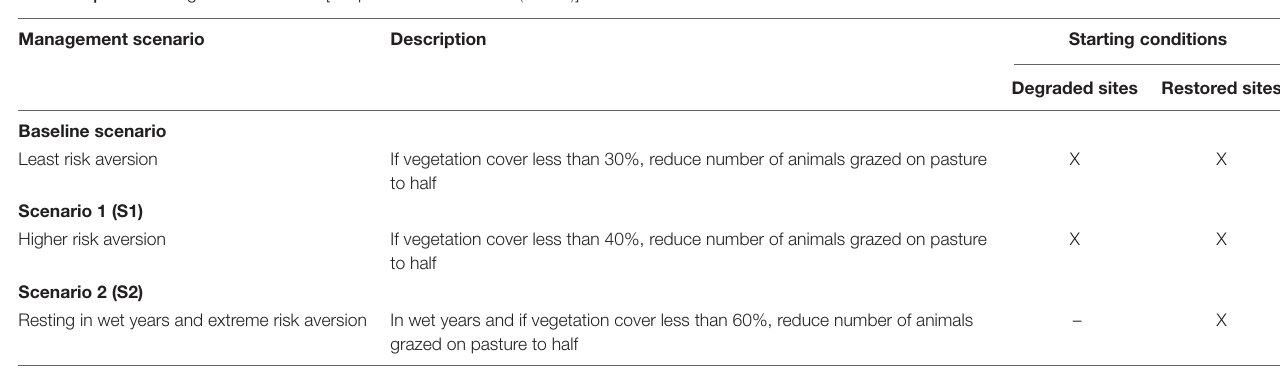
FIGURE 9 | Cost-efficiency of management interventions dependent on stability domains and window of opportunity. Blue, gray, and red areas in panels (A–C) represent gross future values of the benefits of intervention, the benefits that would have occurred without intervention and costs of intervention, respectively. Gross future benefits depend on productivity levels, which vary between stability domains. In panels (D–F) , the same investments of panels (A–C) are converted to discounted (present) value of investment costs and benefits. Dotted lines refer to net present value of intervention (i.e., subtracting from gross benefits the intervention costs and any benefits that would have been obtained without the intervention). The middle panel indicates management effects concurring with a window of opportunity. Note the declining level of initial investment costs and recurrent maintenance costs going from Domain I to Domain III. Investment in Domain I is economically unattractive, in Domain III it can be slightly attractive, while under a window of opportunity, investment in Domain II is economically very attractive. Source: Adapted from Sietz et al. (2017a). TABLE 3 | Land management scenarios [adapted from Sietz et al.